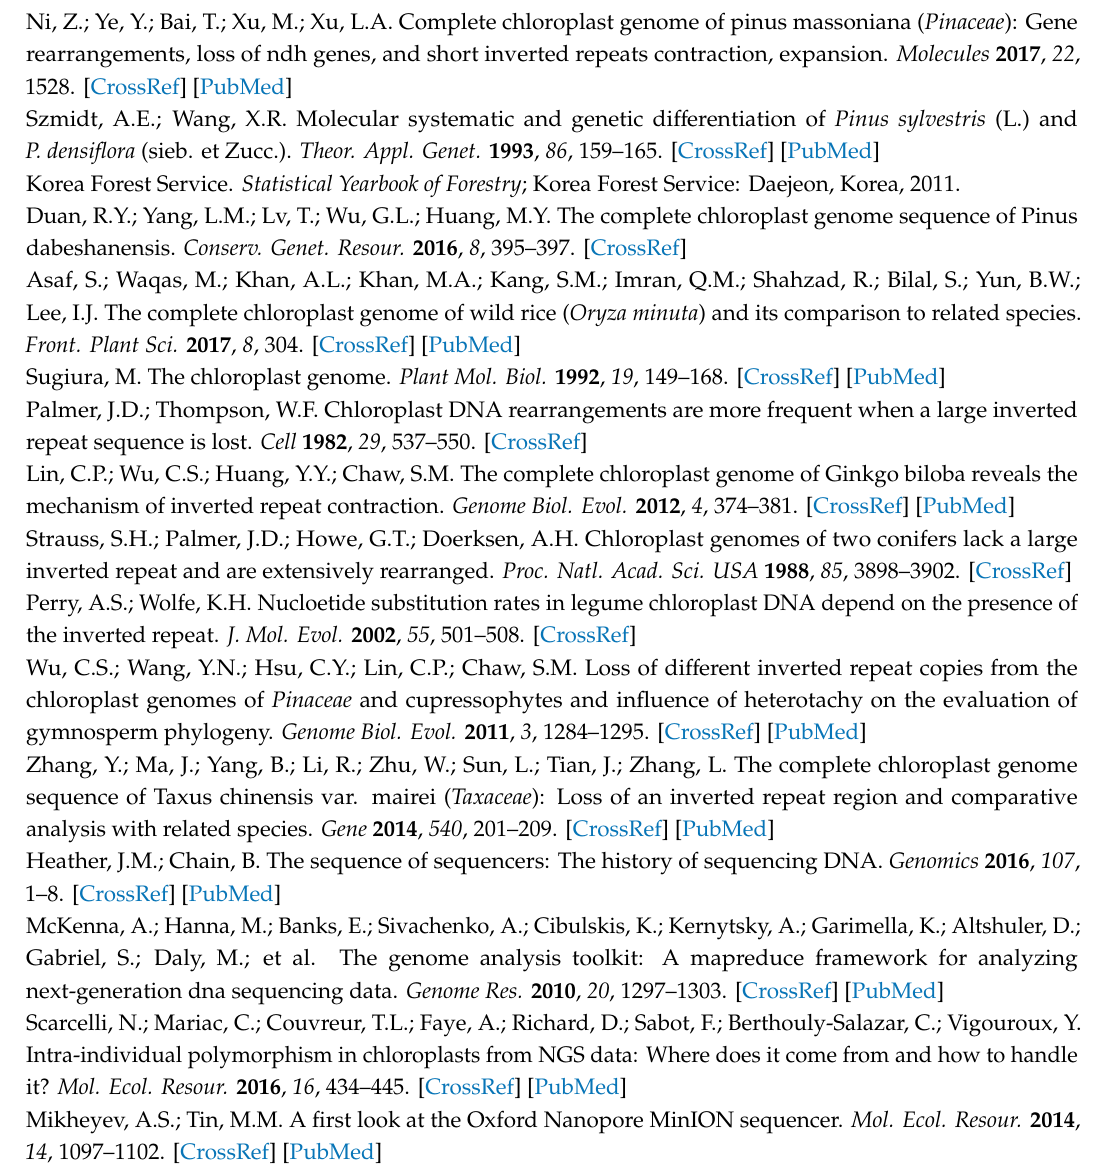
Figure S1: Comparison of complete chloroplast genome of P. densiflora and initial assembled unitig2087 using BLASTZ program. Proximal regions of utg2087 were overlapped approximately 21.9 kb. (A) Initial assembled unitig2087 was used Nanopore reads. (B) Complete chloroplast genome of P. densiflora was corrected using Illumina paired-end reads. Figure S2: BLASTZ analysis of P. densiflora and reference species ( P. sylvestris ). Figure S3: The chloroplast genome sequencing error rate of Oxford Nanopore MinION reads. Supplementary data1: Multiple alignment sequence. Supplementary data2: Parsimony-informative sites for 59 protein coding